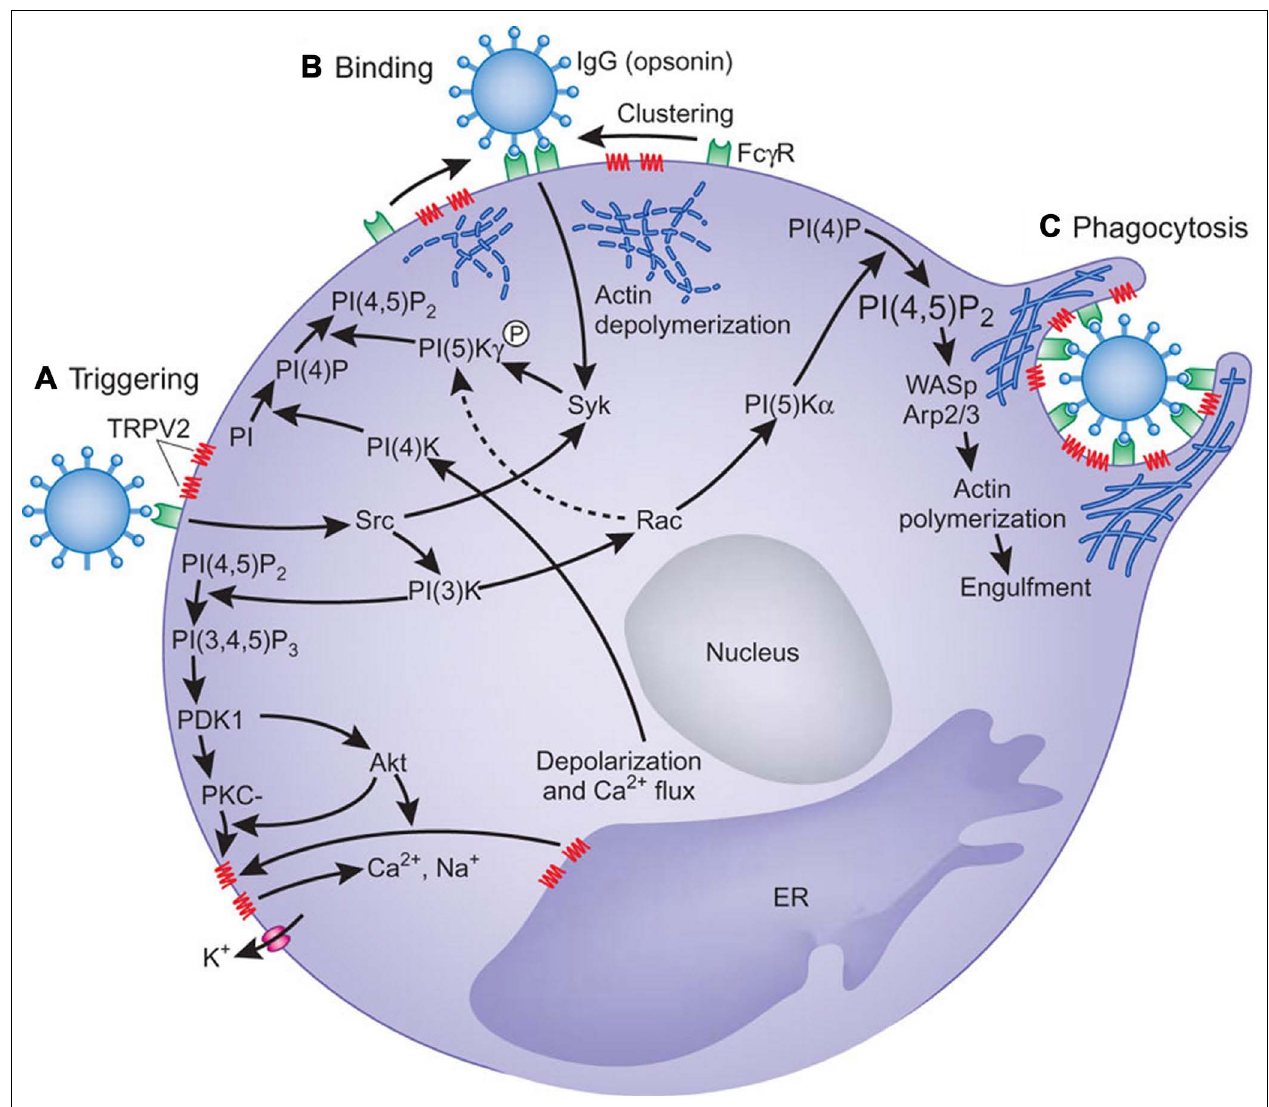
FIGURE 3 |A model for the involvement ofTRPV2 in phagocytosis. (A) Engagement of oligomeric ligands with receptors in the absence of obvious receptor clustering leads to activation ofTRPV2 in a PI(3)K-dependent manner, which results in membrane depolarization. How signals downstream of PI(3)K activateTRPV2 remains unclear. Phosphorylation ofTRPV2, oligomerization of TRPV2, or recruitment ofTRPV2 from intracellular compartment may trigger TRPV2 activation. (B) PtdIns(4,5)P2 (PI(4,5)P2) is synthesized by a combination of type II PI(4)K activated by membrane polarization and PIP(5)K γ activated by Syk. PtdIns(4,5)P2 recruits actin-binding proteins for local actin depolymerization to change local plasma membrane fluidity, thus